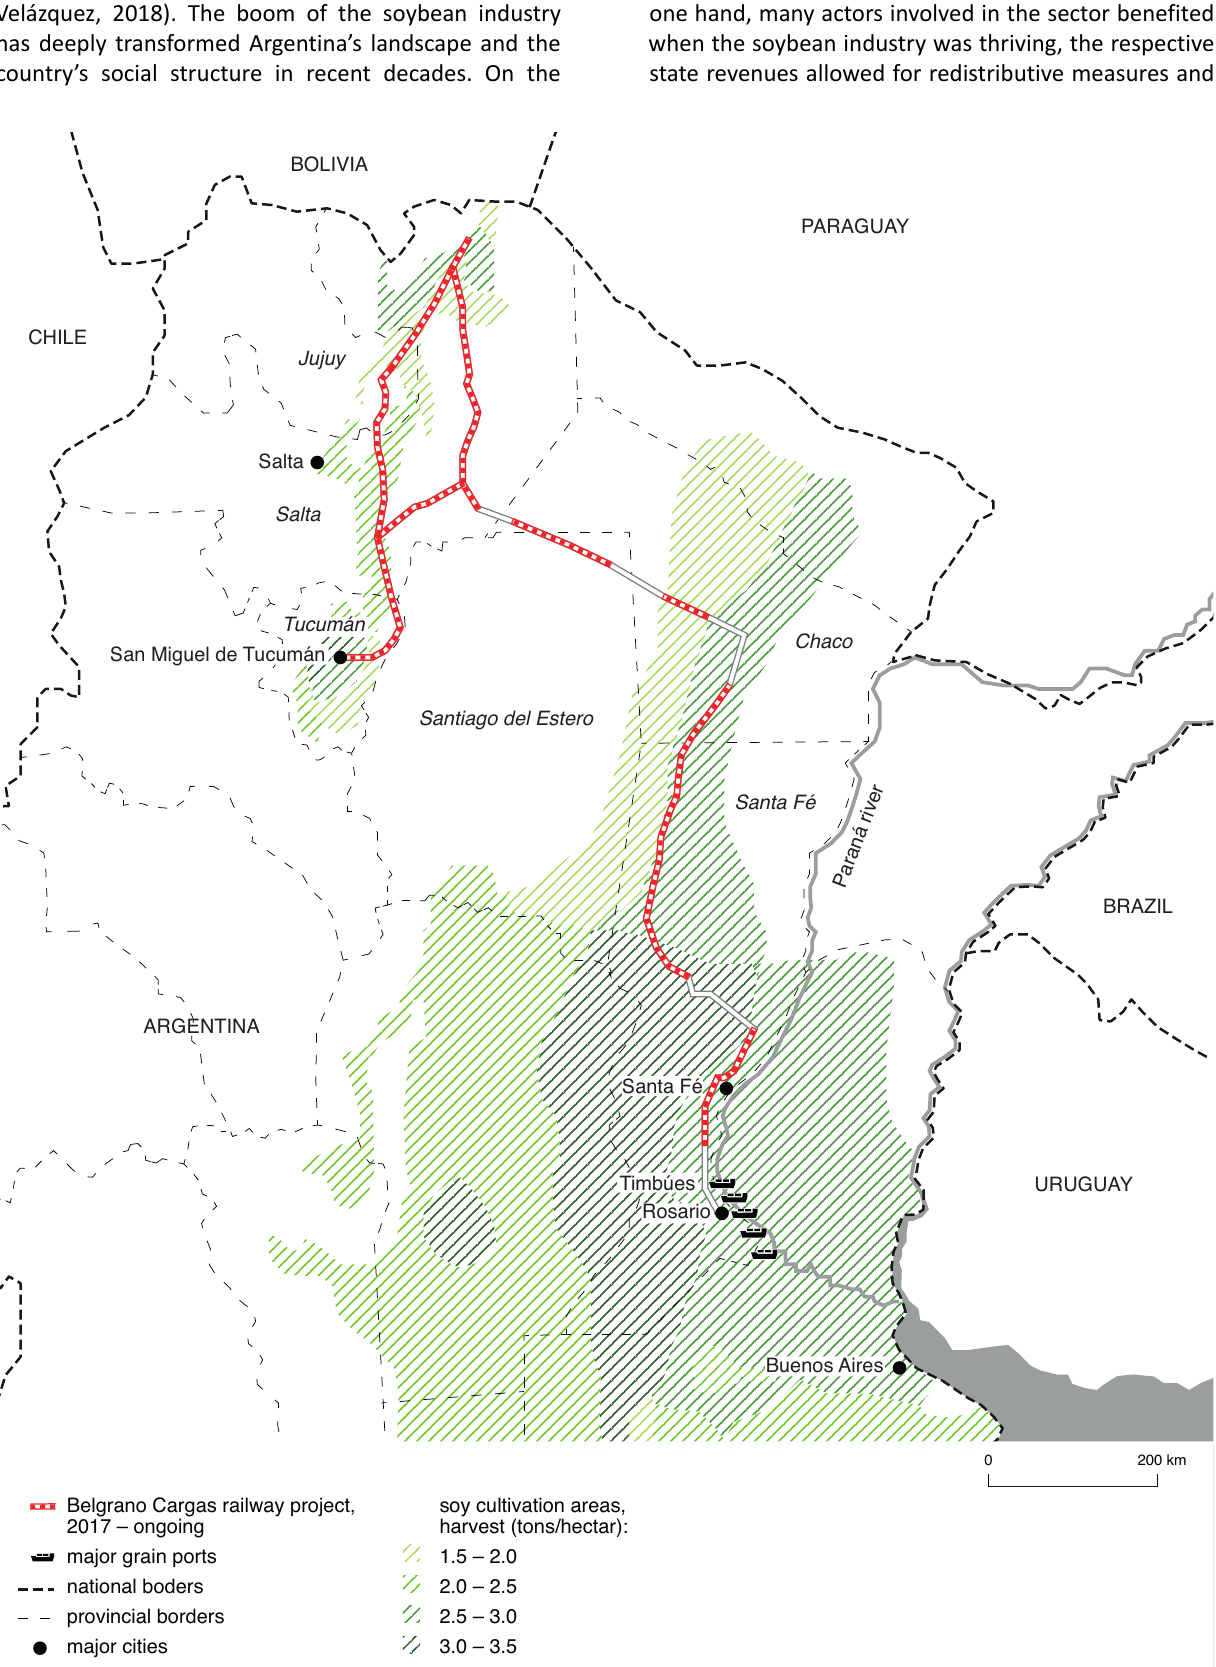
Figure 9. The Belgrano Cargas railway renovation project. Sources: Authors based on Google Maps, OpenStreetMap, Global Yield Gap Atlas (n.d.), and Ministerio de Transporte